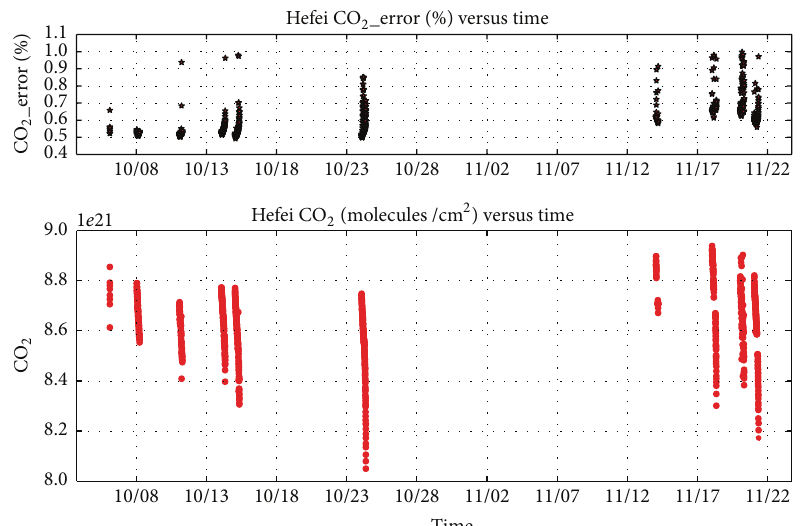
Figure 5: VCD time series ranging from October 6, 2014, to December 1, 2014, which are the average of the retrieval values in 6220 cm −1 CO 2 and 6339 cm −1